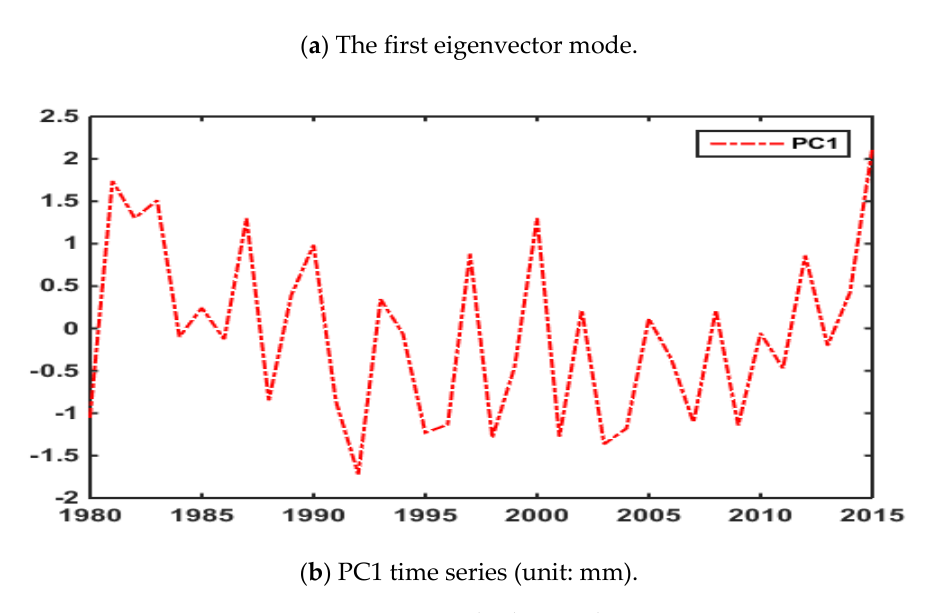
Figure 2. First leading mode.